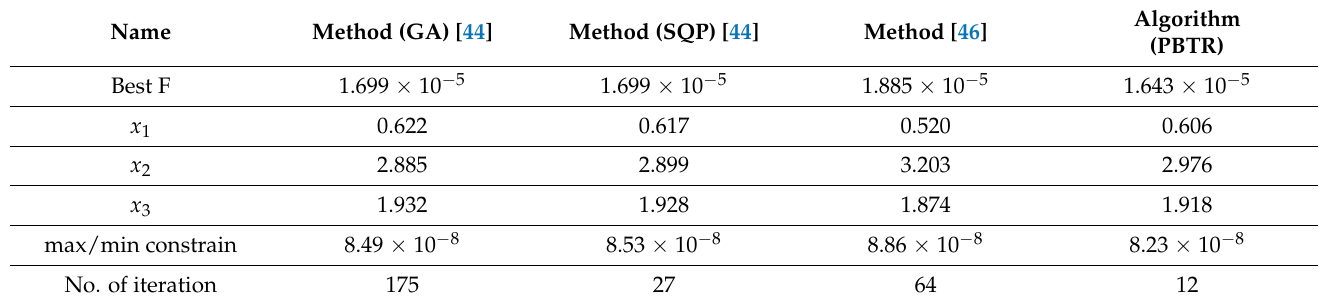
Table 2. Comparison of methods in [44,46] with the PBTR